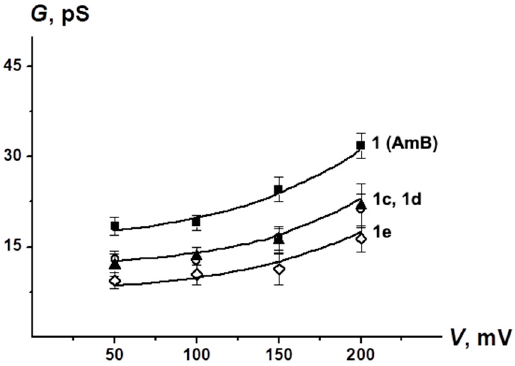
Figure 5. G–V curves of single channels produced by AmB, 1c , 1d and 1e . Membranes were made from DPhPC/ERG (67/33 mol %) and bathed in 2.0 M KCl (pH 7.4). Table 4. Characteristic parameters of the single ion-permeable pores induced by different AmB derivatives in DPhPC/Erg (67/33 mol %) bilayers. Polyene G 200 mV 1 , pS τ 2 , ms P op 3